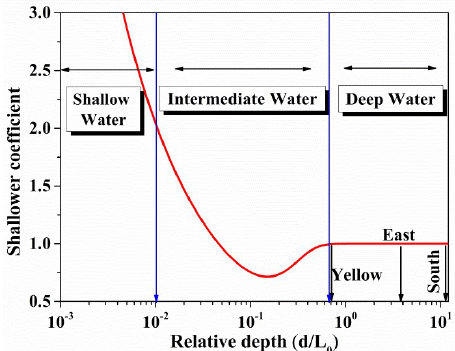
Figure 6. A typical example for the shallower coefficient: variation of the relative water depth for wind seed of 10 m/s. As the relative water depth increases, the shallower coefficient will be close to 1.0 for deep water.